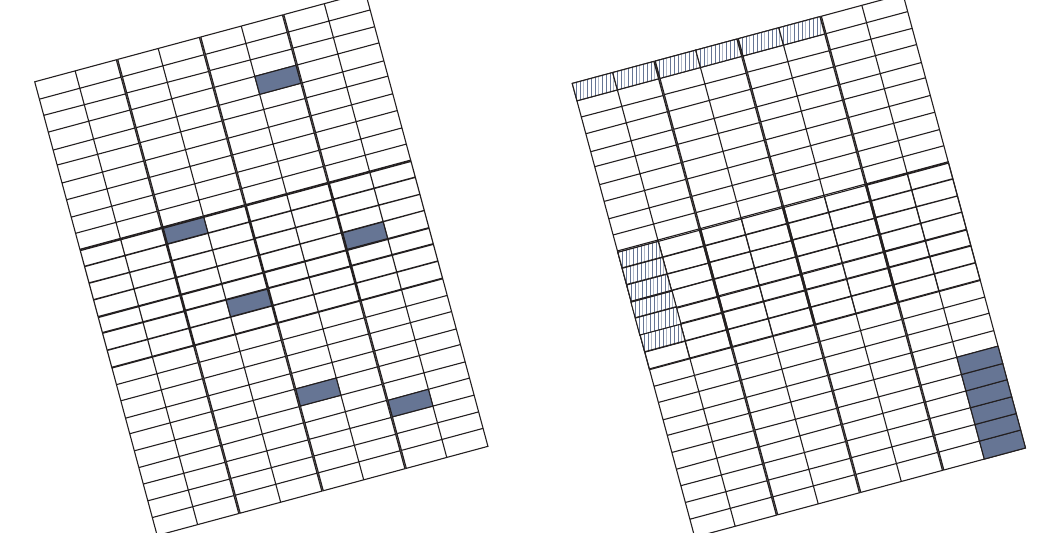
Figure 4. Land plots consolidation at the land mass boundary after exchange